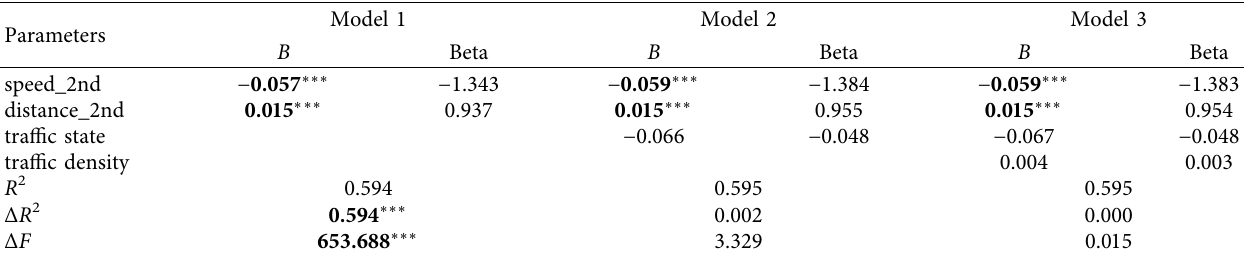
Table 6: Regression analysis results of the maximum deceleration.